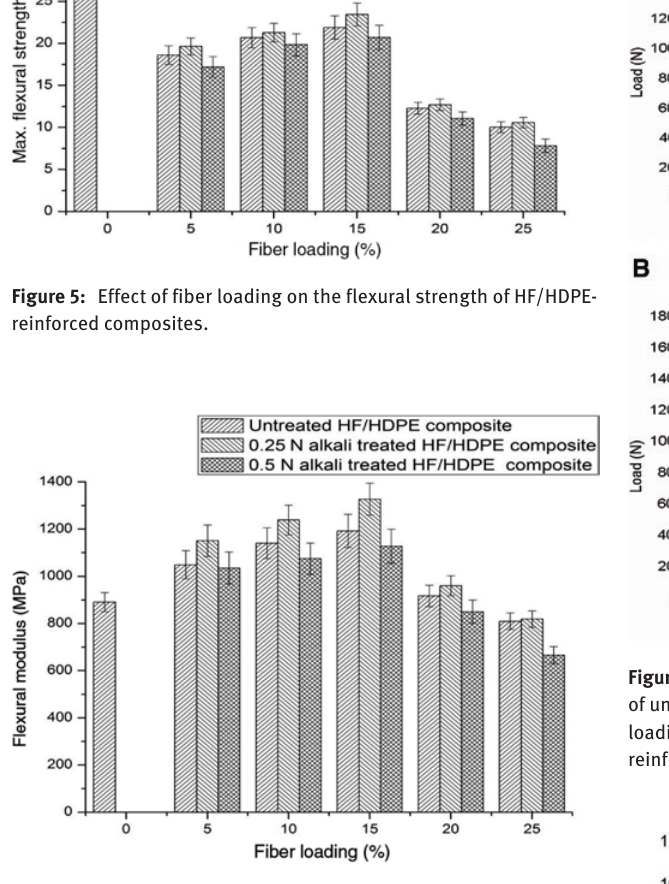
Figure 6: Effect of fiber loading on the flexural modulus of HF/ HDPE-reinforced composites.